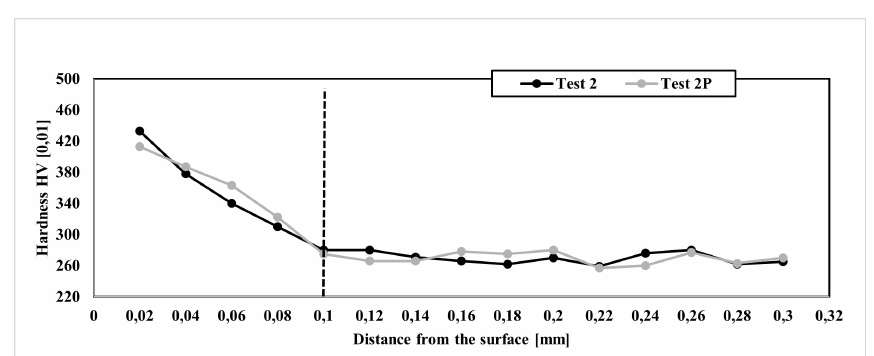
Figure 4. Hardness values of samples - Test 1 and Test 1P.